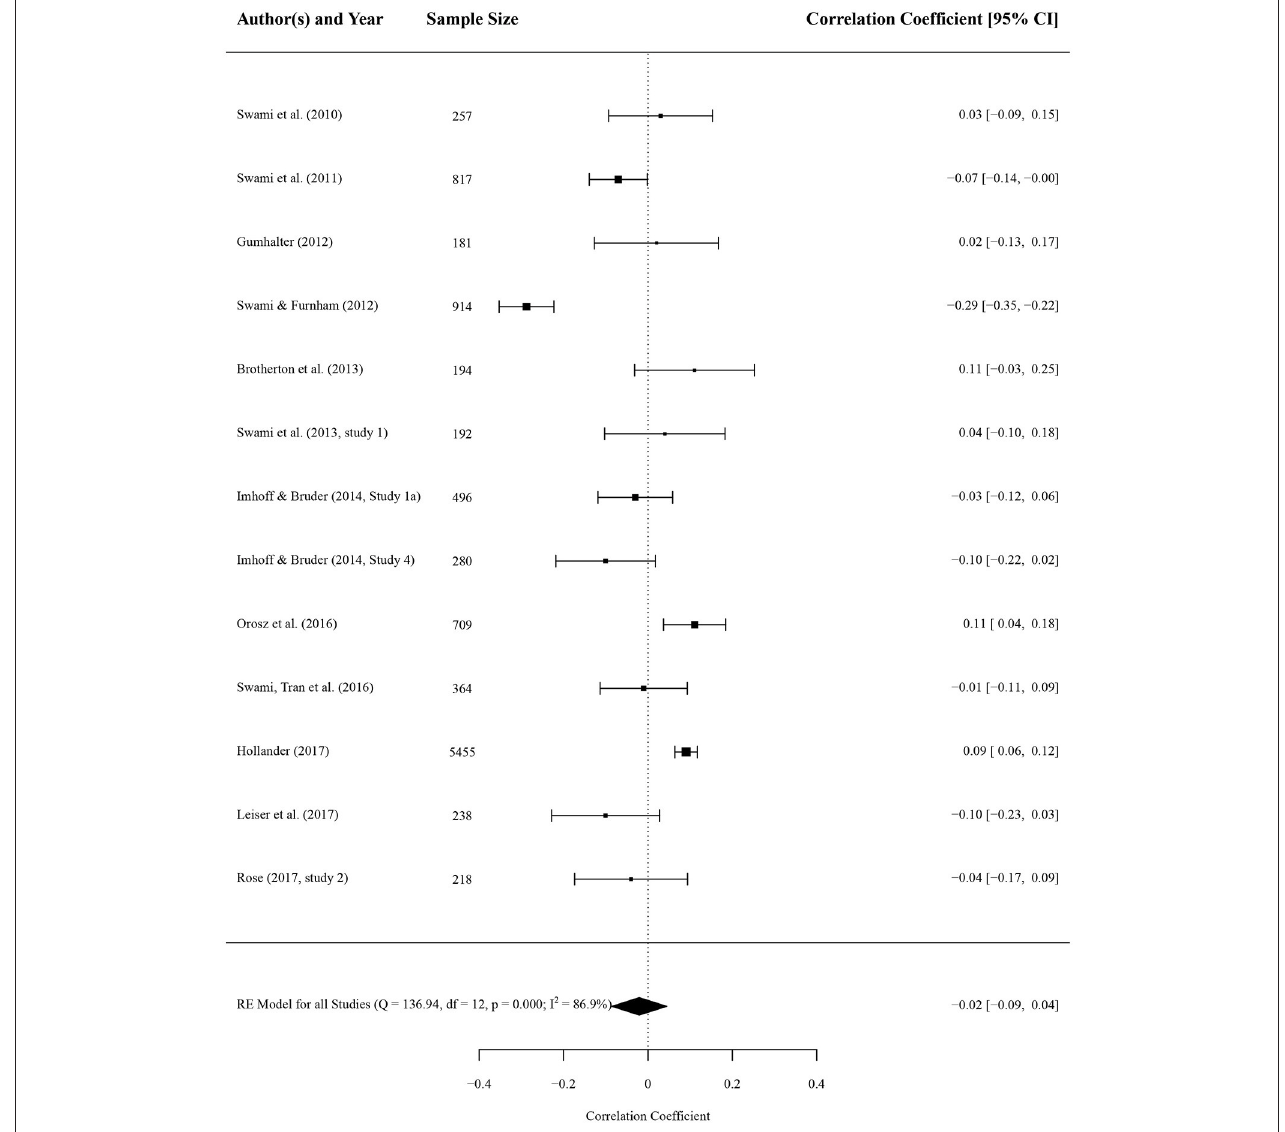
FIGURE 3 | Forest plot of correlation coefficients between conspiracy beliefs and agreeableness. A positive effect size indicates that higher levels of conspiracy beliefs is associated with higher levels of agreeableness. Average effect was calculated using a random-effects